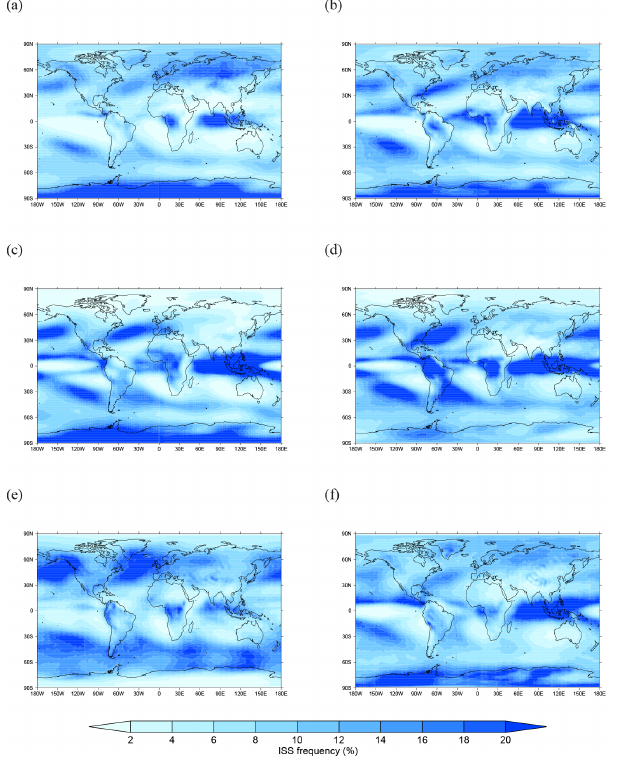
Figure 2. Annual-mean CISS frequency at 250hPa over the present-day period 1979–2005 for (a) ERA-Interim reanalysis and the CMIP5 models (b) EC-EARTH, (c) GFDL-ESM2G, (d) HadGEM2-CC, (e) MIROC5 and (f) MPI-ESM-MR. The CISS fields for the five CMIP5 models are repeated in Fig. 4 as labelled